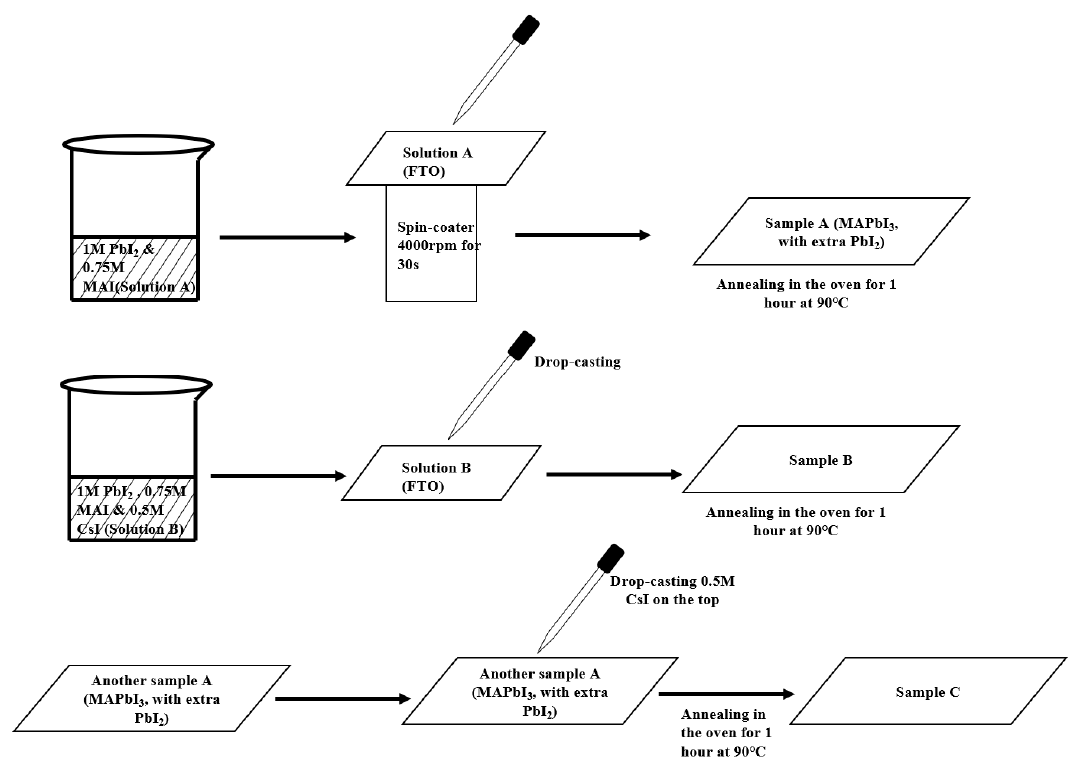
Figure 1. Synthesis of sample A (MAPbI 3 ), sample B (a mixture of MAPbI 3 , CsI, and CsPbI 3 ) and sample C (surface-passivated MAPbI 3 ). MAI: methylammonium iodide; FTO: fluorine-doped tin oxide .